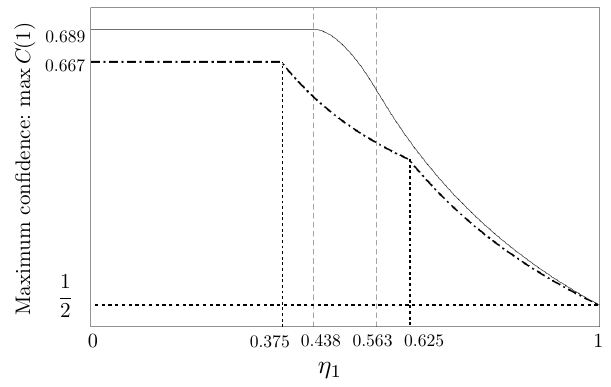
FIG. 8. The certifiable maximum confidence is shown for two noisy states c 1,2 = 1 / 2 and p = 1 / 2, where p is the noise param- eter in Eq. (52). The certifiable maximum confidence varies depending on an outcome rate η 1 . The certifiable maximum confidence for quantum states (solid) is higher than that in a noncontextual model (dotted) for all η 1 ∈ [0,